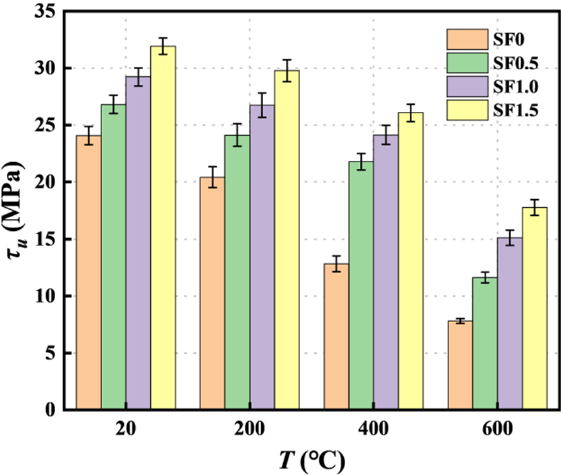
Figure 10. Ultimate bond stress at different high temperatures. The effect of V f on bond strength is shown in Figure 11. With the increase in V f , β V generally shows a linear growth trend. β V is small at 20 ◦ C and 200 ◦ C, i.e., less than 1.5 in both cases. The slope of the β V – V f curve is steeper between 400 and 600 ◦ C, which indicates that the effect of V f on the improvement in bond strength is more obvious between 400 and 600 ◦ C.